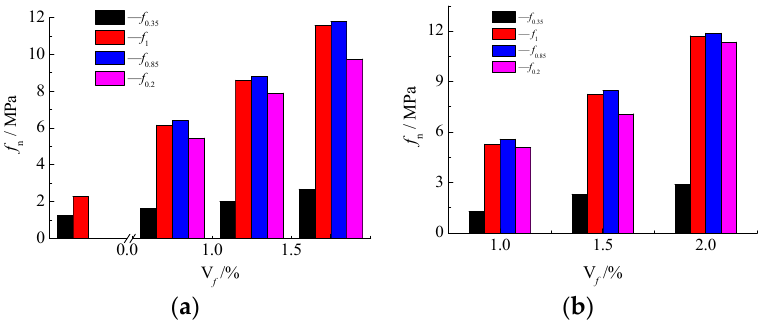
Figure 12. Effect of fiber content on f n : ( a ) 56 d; ( b ) 28